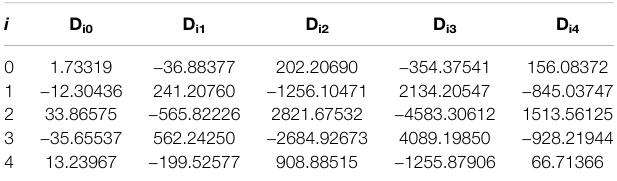
TABLE 11 | Coef fi cients D ij of λ ( ρ , T ) .